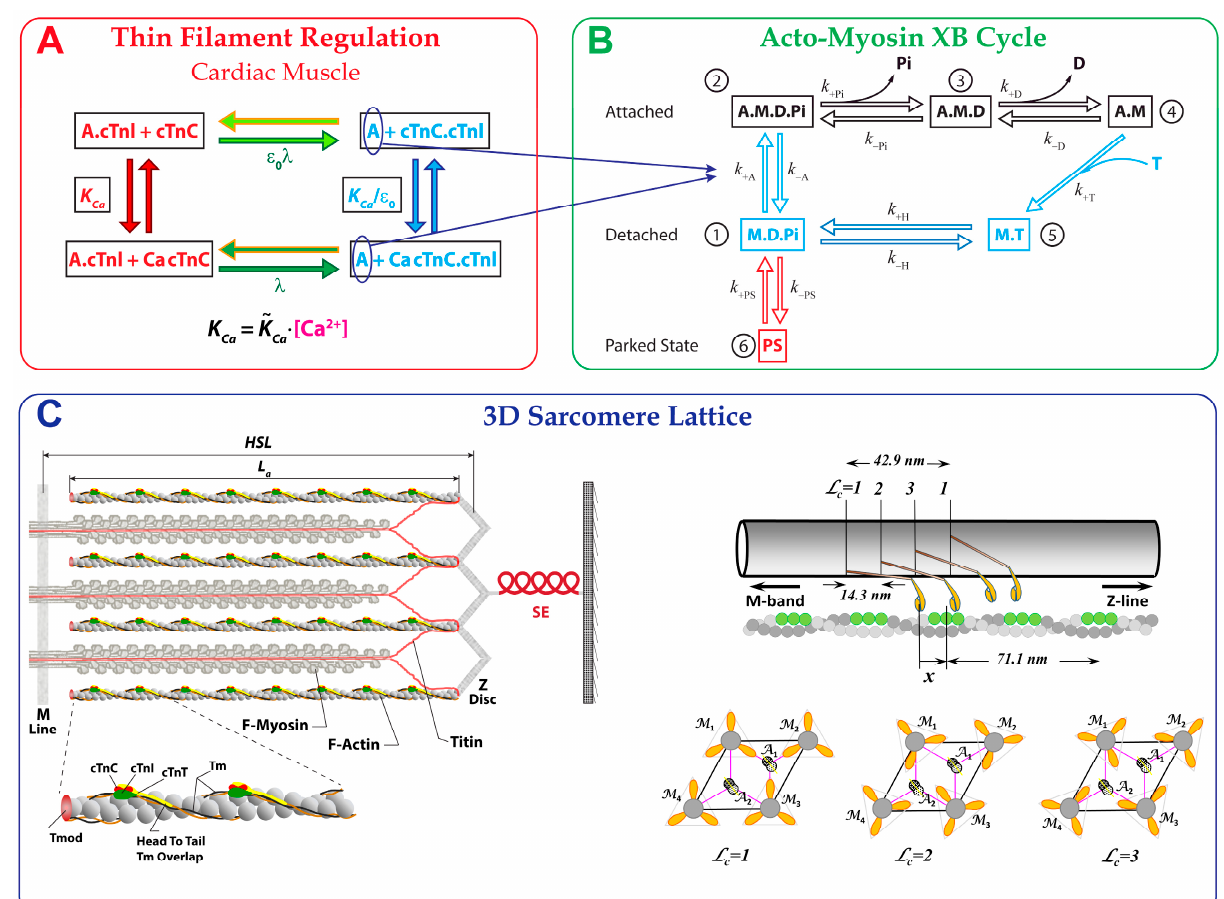
Figure 1. Schematic representation of MUSICO platform in reference to the 3D half-sarcomere structure. ( A ) Kinetic scheme of calcium-binding to cTnC and interaction of cTnI with actin in cardiac muscle. Calcium-binding to cTnC forms a CacTnC complex, with an equilibrium rate of K Ca = (cid:101) K Ca · [Ca 2+ ], where (cid:101) K Ca is a rate constant and [Ca 2+ ] is the instantaneous calcium concentration. Conformational changes within the cTn molecule forming the cTnC.cTnI or CacTnC.TnI complex, which have a low affinity to actin, are defined by the equilibrium state transition rate λ . In the CacTnC.cTnI (or cTnC.cTnI) state(s), cTnI is dissociated from actin, enabling Tpm to move freely, mostly azimuthally, and permitting myosin-binding and force generation. The rate of calcium-binding to cTnC.TnI to form a CacTnC.cTnI complex is accelerated by a factor of 1/ ε o . ( B ) Six-state model of the actomyosin cycle includes five biochemical states consistent with observed structural states: M.D.Pi, A.M.D.Pi, A.M.D, A.M and M.T. The strain-dependent state transition rates are associated with conformational changes defining the structural conformations of myosin in each state (for details, see [1,15]). An additional sixth state, the so-called “parked state” (PS), represents the interaction of myosin heads with the thick filament backbone. The transition rate from PS to M.D.Pi is assumed to be strongly dependent on [Ca 2+ ], and the reverse rate is independent of [Ca 2+ ]. ( C ) The 3D structural organization of sarcomeres includes thick (myosin) filaments interdigitated with thin filaments composed of actin and regulatory proteins, along with the ancillary protein titin. The 3D formulation includes an azimuthal shift of myosin crowns ( L c = 1, 2, 3), where the interaction of crossbridges with the target zones ( green filled circles ) on an actin filament is defined by axial crossbridge distortion and azimuthal angles defining the positions of actin filaments relative to the myosin filament and the positions of myosin-binding sites on actin (for